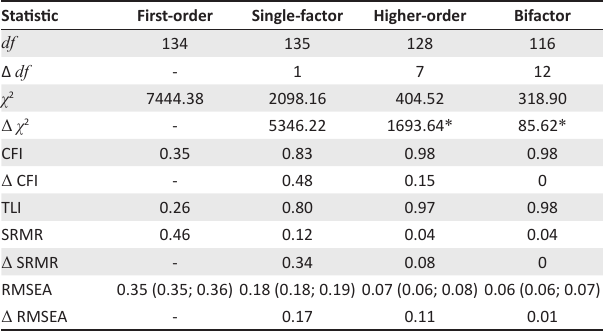
TABLE 3: Fit statistics for a first-order, single-factor, higher-order factor, and bifactor model of goal